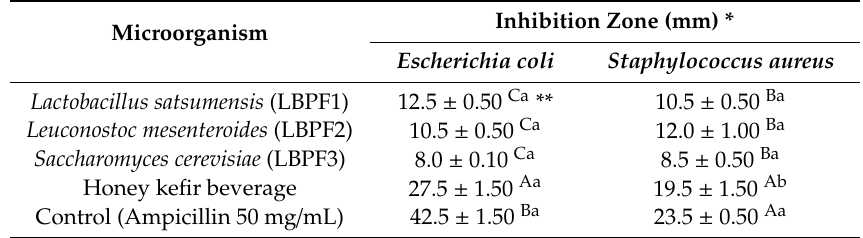
Table 1. Antimicrobial activity of Lactobacillus satsumensis LPBF1, Leuconostoc mesenteroides LPBF2